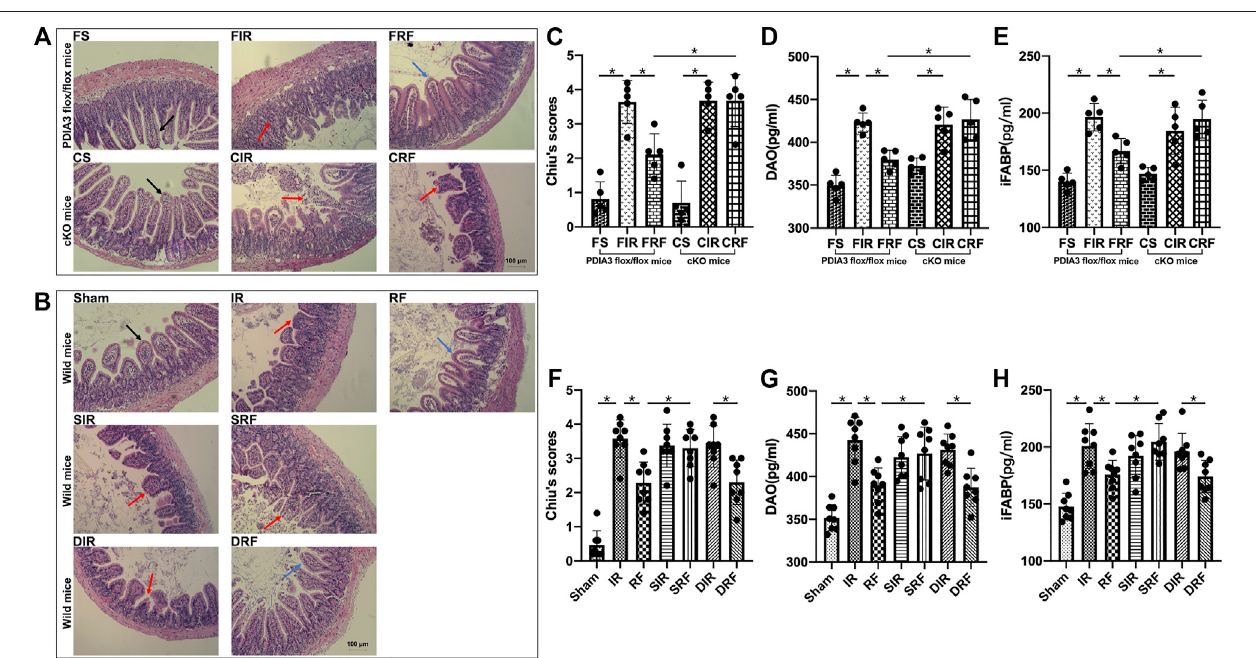
FIGURE 2 | Ischemia/reperfusion injury in the intestine. Groups are the same as in Figure 1 . Histopathologic changes of the intestinal mucosa were assessed by hematoxylin and eosin staining (A,B) , and intestinal injury was evaluated using Chiu ’ s scores (C,F) under light microscopy (×200, scale bar: 100 μ m), diamine oxidase activity (DAO) (D,G) , and intestinal fatty acid – binding protein (iFABP) (E,H) in serum. In the FS, CS, and sham groups, normal intestinal villi and glands are seen and shown by black arrows. In the FIR, CIR, CRF, IR, SIR, SRF, and DIR groups, injured intestinal gland, disintegrated intestinal villi, and signi fi cantly increased gap betweenepithelialcellsareobservedandshownbyredarrows,indicatingseveremucosaldamage.IntheFRF,RF,andDRFgroups,nosigni fi cantedemainintestinalvilli is seen, and extension of the subepithelial space (Gruenhagen space) was developed, which are shown by blue arrows, indicating slight mucosal damage. Data are expressed as mean ± SD, n = 5 – 8. The results were compared by ANOVA with Tukey ’ s post hoc test. * P < .05.